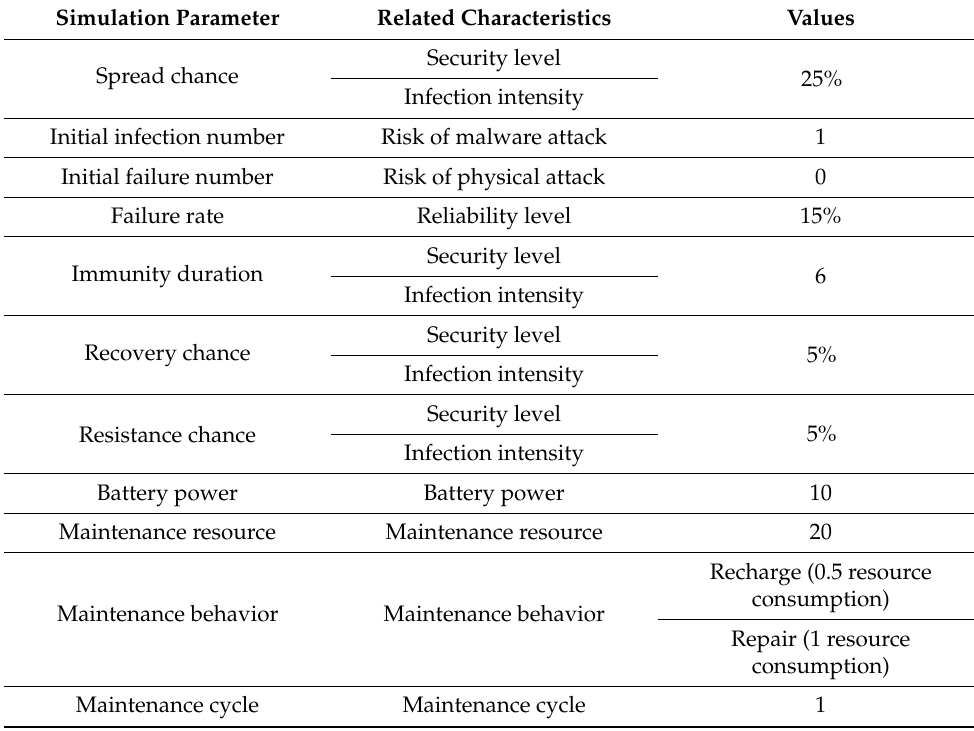
Table A7. Scenario 3 with simulation parameters and